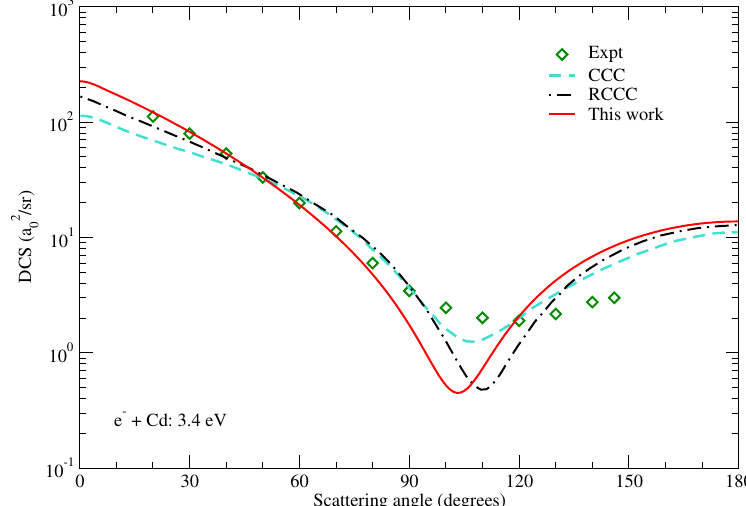
Figure 3. Differential elastic cross section for electron–Cd at 3.4 eV compared to the data of Marinkovi´c et al. [5] and Berrington et al. [12]. The relative DCS data were normalized at 50